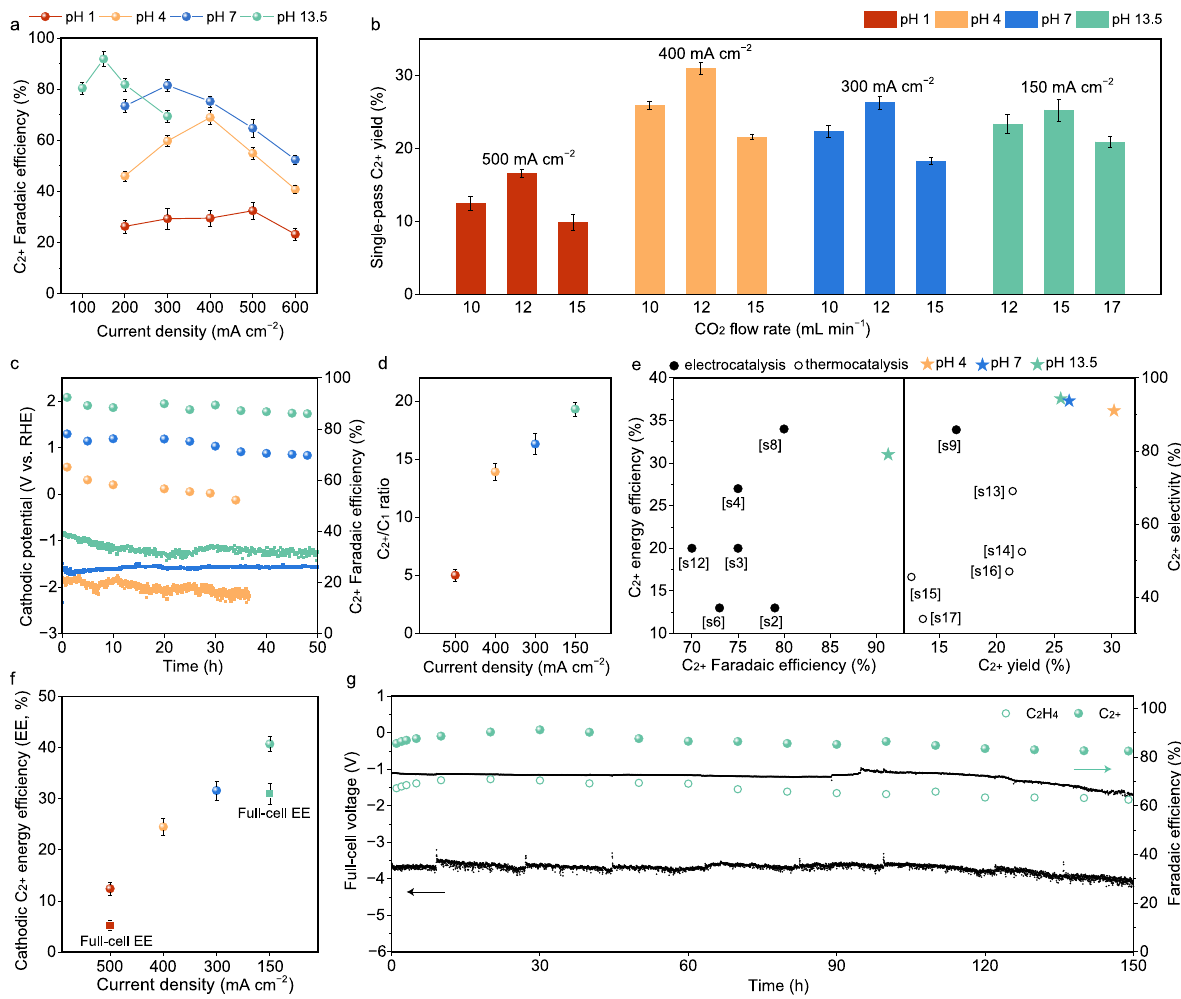
Fig.4|ElectrochemicalCO 2 RperformanceonCu 0.9 Zn 0.1 catalystsfabricatedby co-sputtering and wet-chemical-etching at pH 1 – 13.5. a C 2+ FEs at different current densities at pH 1, 4, 7, and 13.5, respectively. b Single-pass C 2+ yield at differentCO